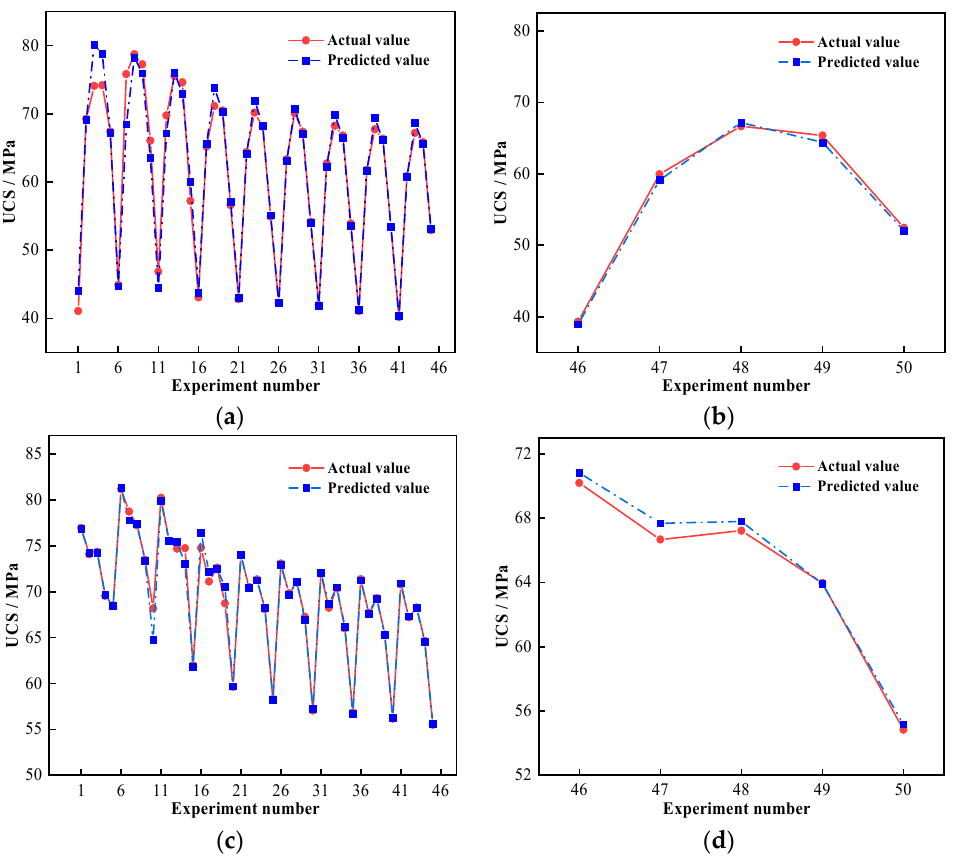
Figure 8. Comparison of prediction results of the training set and the test set: ( a ) Training set of sample A; ( b ) Testing set of sample A; ( c ) Training set of sample M; ( d ) Testing set of sample M.